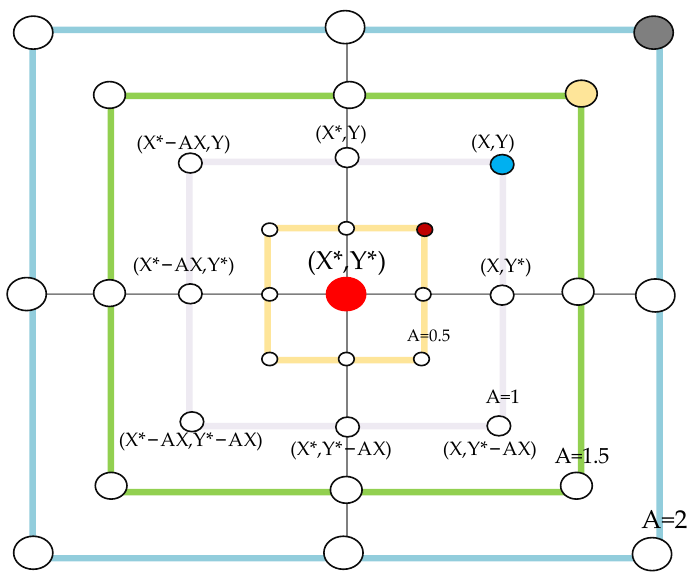
Figure 5. Exploration mechanism implemented in the WOA ( X* is a randomly chosen search agent).